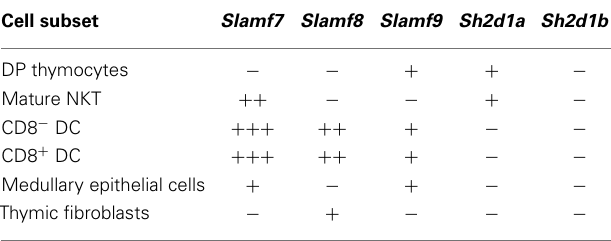
Table 1 | mRNA levels in SAP-independent SLAMF receptors and SLAMF adaptors expressed by different murine thymic